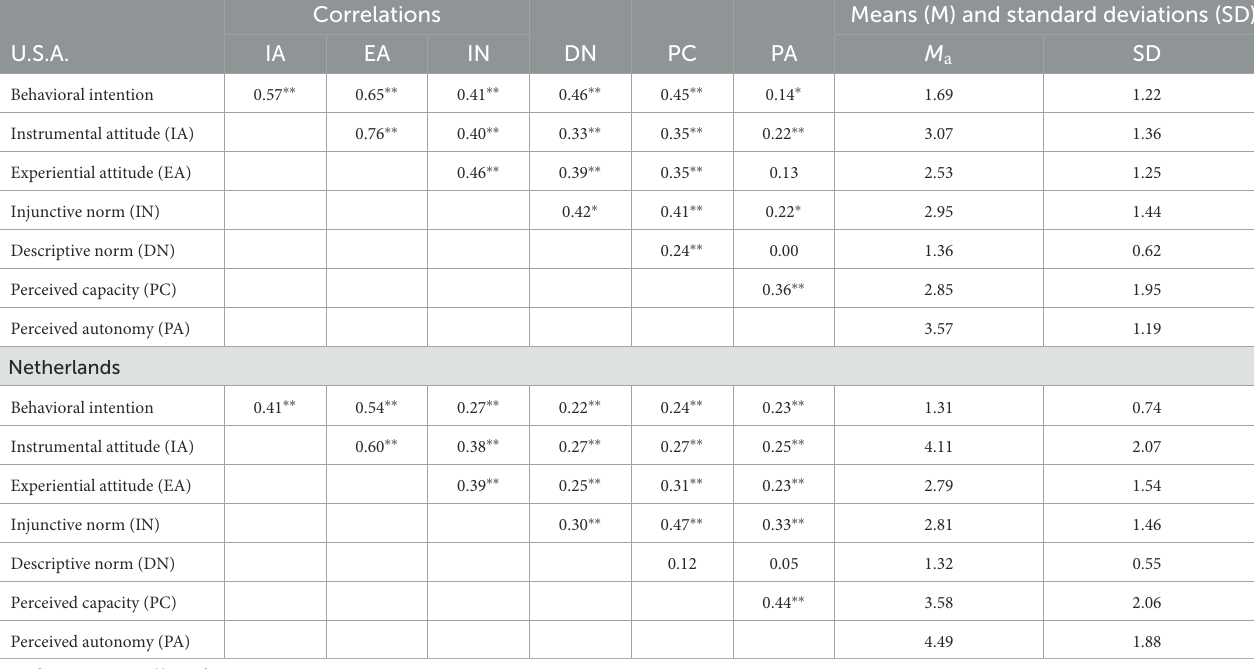
TABLE 5 Descriptive statistics: correlations, means, and standard deviations for having a vegan diet.